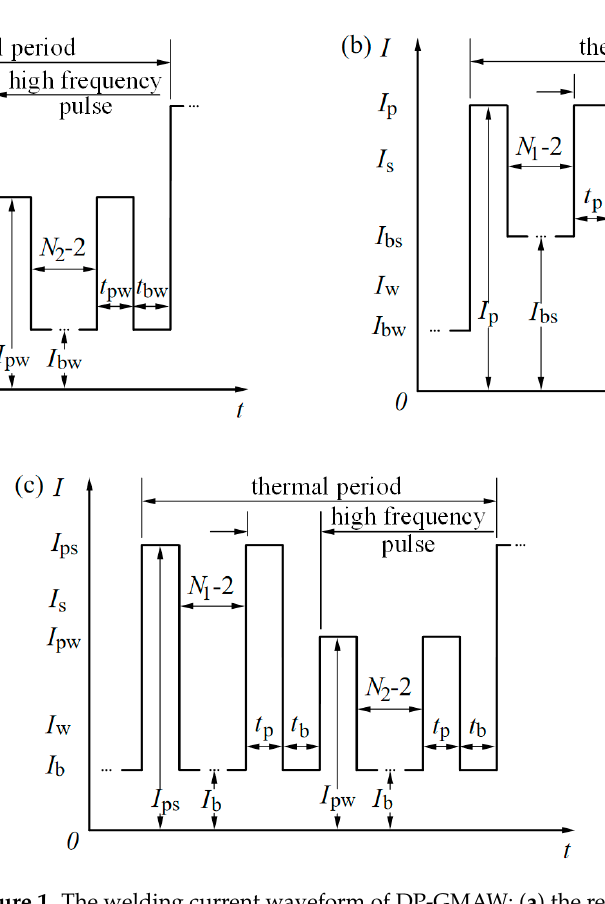
Figure 1. The welding current waveform of DP-GMAW: ( a ) the representative welding current waveform; ( b ) the simplified welding current waveform 1; ( c ) the simplified welding current waveform 2. Two simplified current waveforms of DP-GMAW are shown in Figure 1b,c,